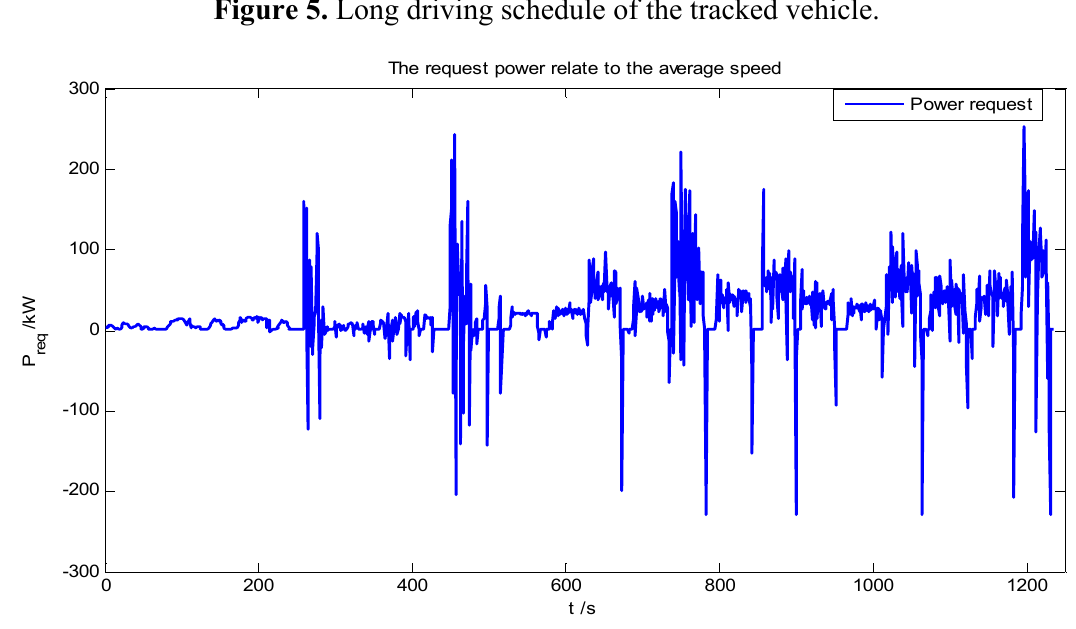
Figure 6. Power request of the long driving